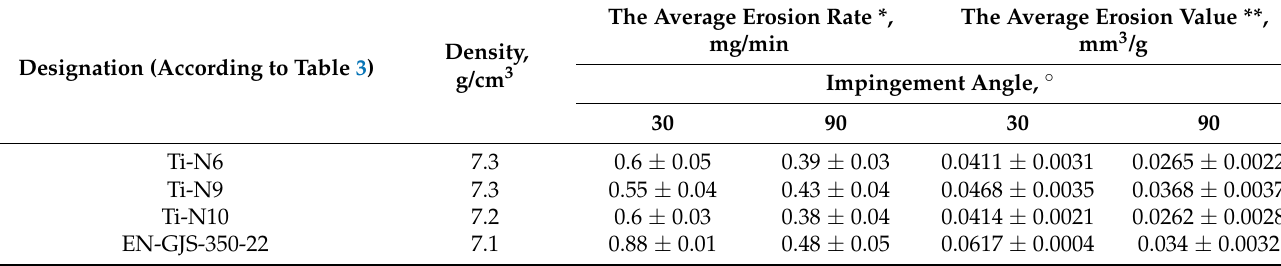
Table 7. The solid particle erosion test